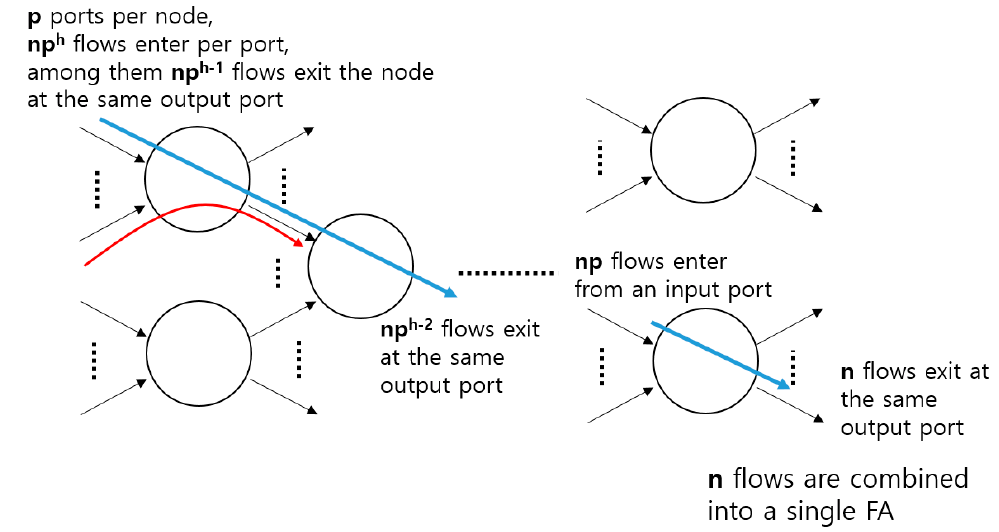
Figure 5. Architecture of the network used for the analysis.